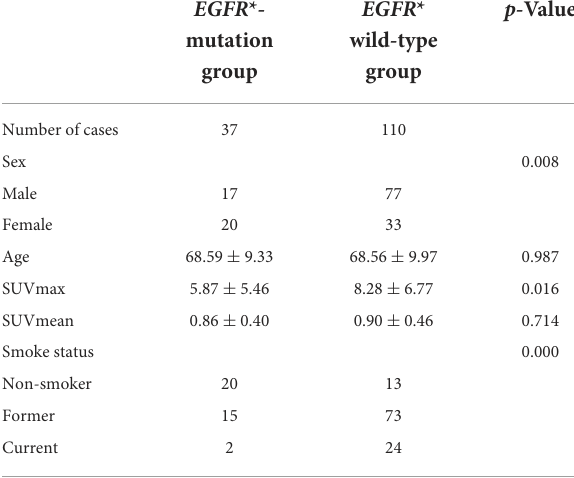
TABLE 1 Clinical characteristics of